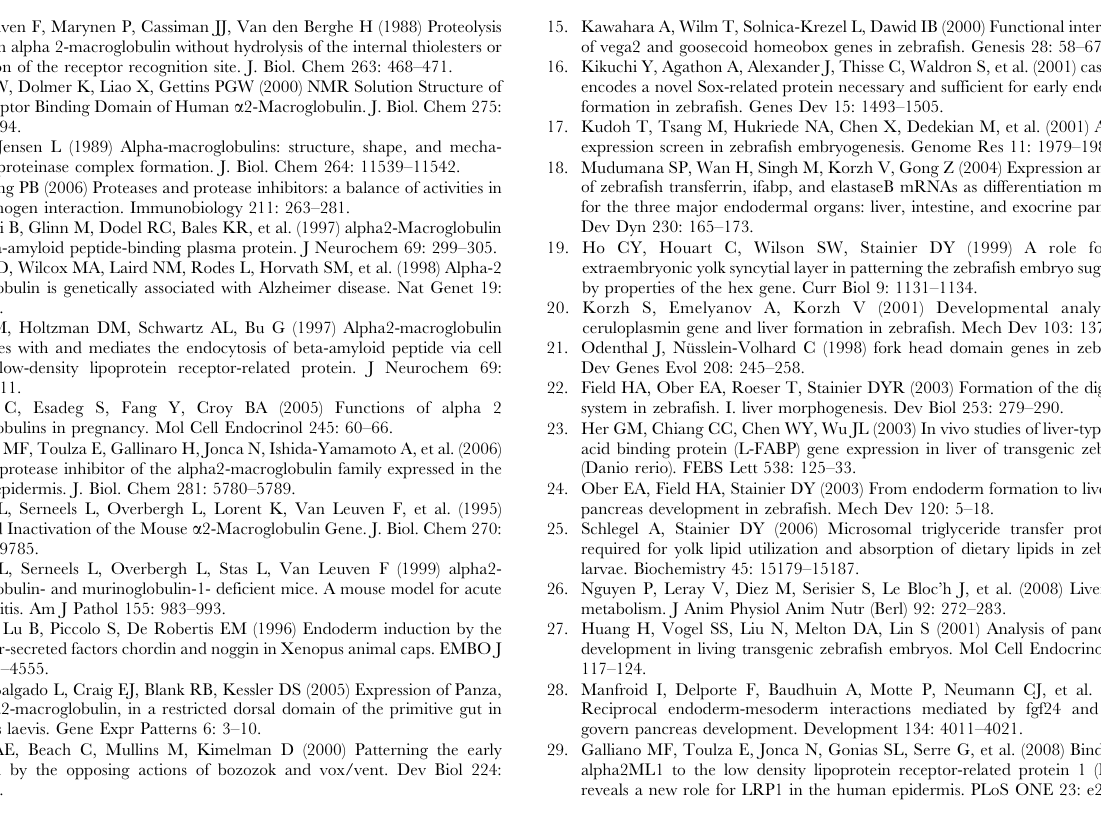
Figure S1 Amino acid comparison of A2ML family. Amino acid comparison of a 2ML family. A. Schematic representation of amino acid sequence comparison between species. The percentage identity to zebrafish a 2 macroglobulin-like is given for